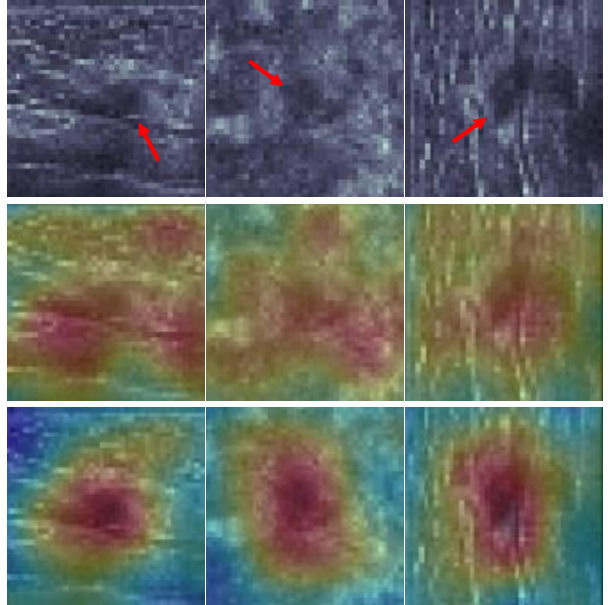
Figure 1. Class activation maps (CAMs) for sample mass images. The first row shows slice images of the breast mass in different views: transverse ( left ), coronal ( middle ), and sagittal ( right ). The second row shows the CAM results from the existing DenseNet classifier. The third rows show the CAM results from the proposed method. An activation with a high weight is shown in red color.